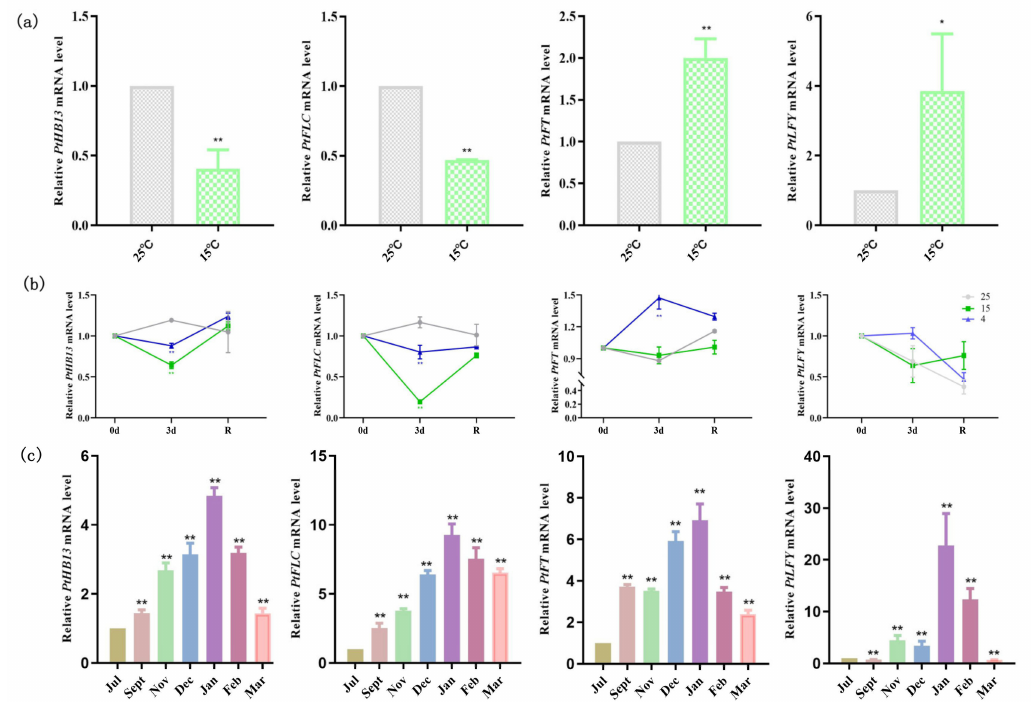
Figure 5. PtFLC , PtHB13 , PtFT , and PtLFY are regulated by temperature changes in citrus. ( a ) Relative expression levels of PtFLC , PtHB13 , PtFT , and PtLFY in citrus callus at 25 ◦ C and 15 ◦ C for 1 day. ( b ) Changes in transcript levels of PtFLC , PtHB13 , PtFT , and PtLFY under low-temperature conditions. ( c ) Relative expression levels of PtFLC , PtHB13 , PtFT , and PtLFY in citrus trees buds from July to March. Asterisks indicate significant di ff erences (Student’s t -test): ** P <